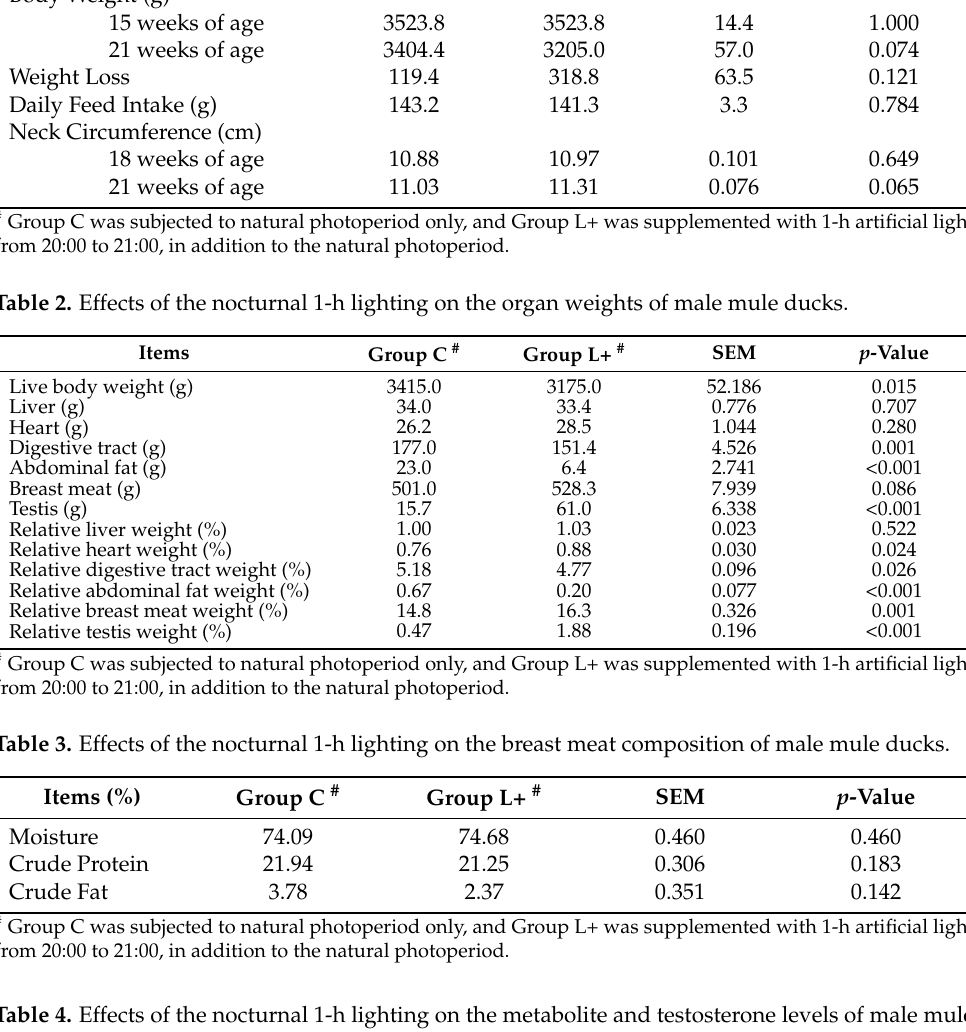
Table 4. Effects of the nocturnal 1-h lighting on the metabolite and testosterone levels of male mule ducks.